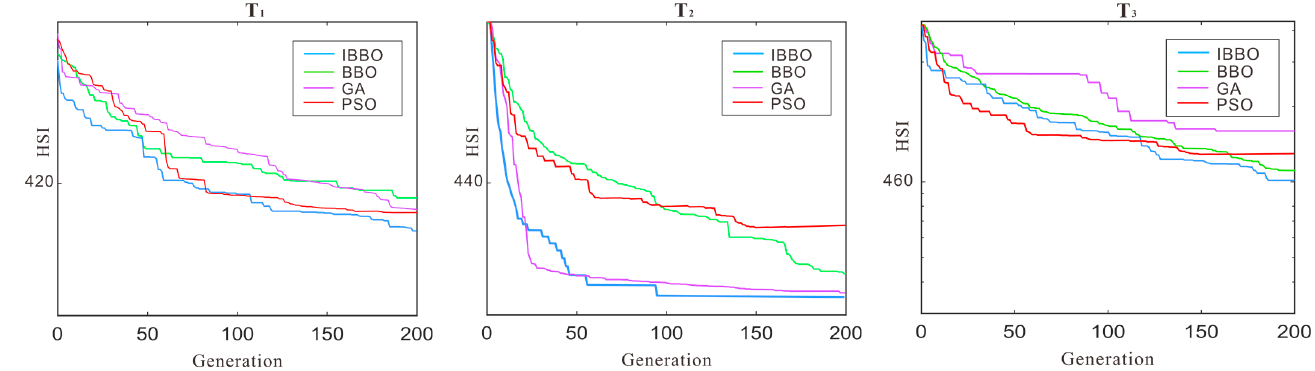
Figure 15. Comparison charts of INSBBO and NSBBO solving the upper objective function Pareto front solution in different time domains.